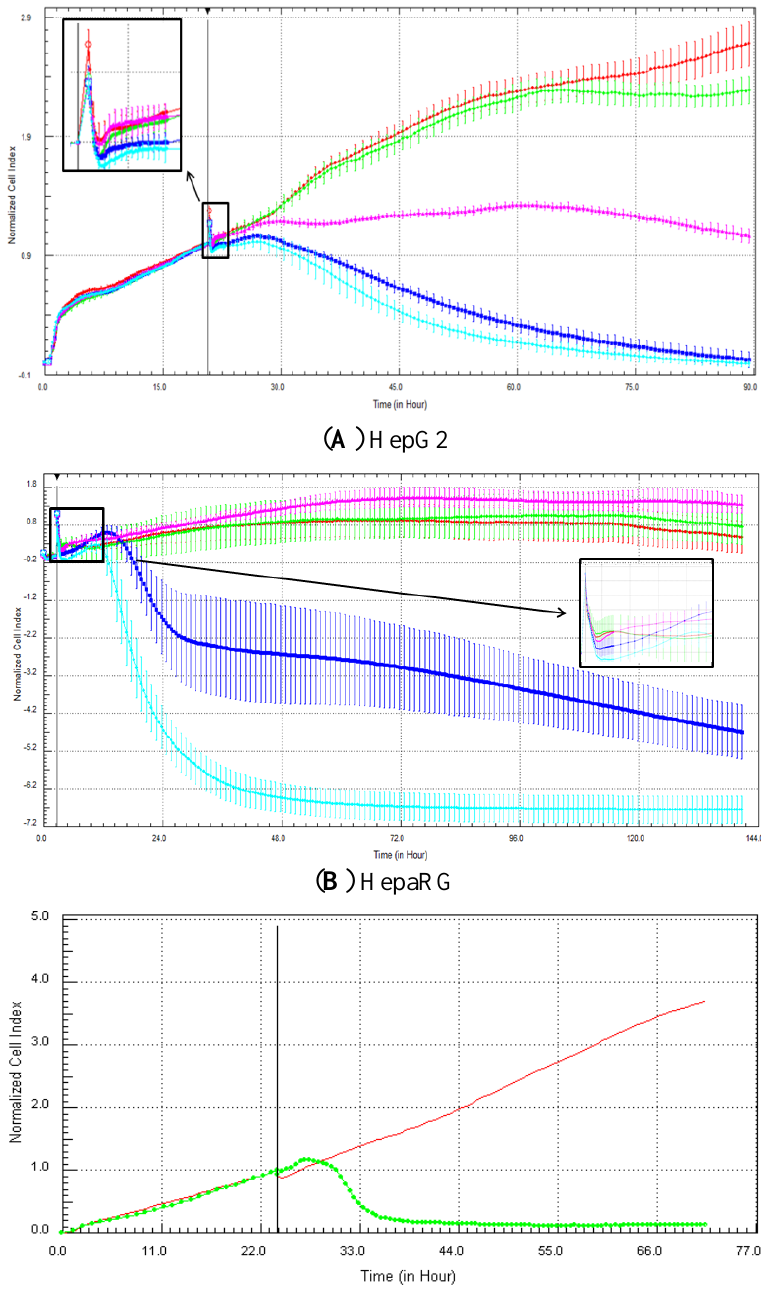
Figure 5. Effect of strophanthidin (DNA damaging) on cell index curves (RTCA) in HepG2, fresh HepaRG and A549 cells. HepG2 ( A ) and HepaRG ( B ) cells were exposed for at least 72 h to 0 (0.5% DMSO, red curve), 0.1 (green curve), 1 (purple curve), 10 (dark blue curve) and 100 (light blue curve) µM and A549 cells to 0 (control DMSO, red curve) and 20 µM (green curve) of nocodazole ( C from Abassi et al. [9]). Cell indexes were normalized with the last time point before compound addition. Panels A and B: each data point was calculated from triplicate values (except for control cells n = 6). Data represent average ± standard deviation (except for panel C). The normalized time point is indicated by the vertical line. For more details, please refer to the Materials and Methods section. A zoom is provided in case of overlapping